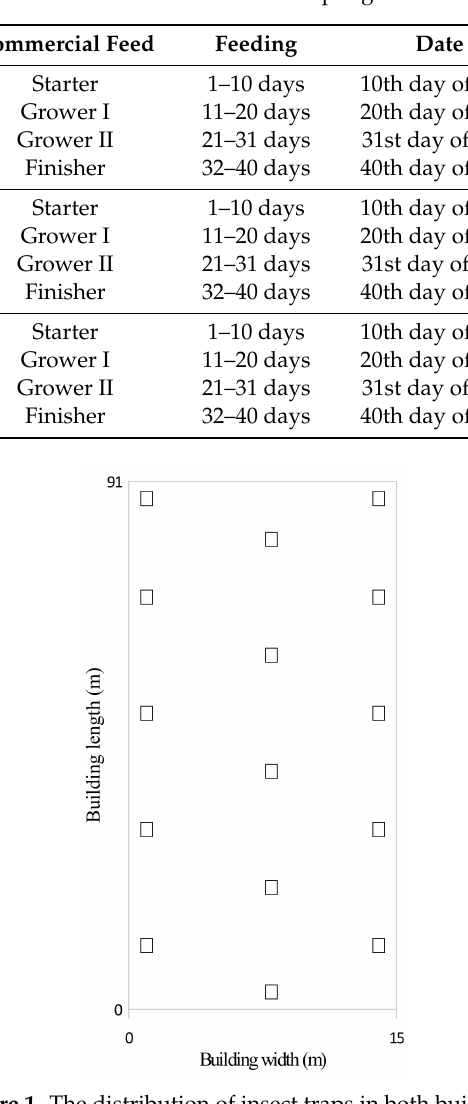
Table 3. Dates of sampling.